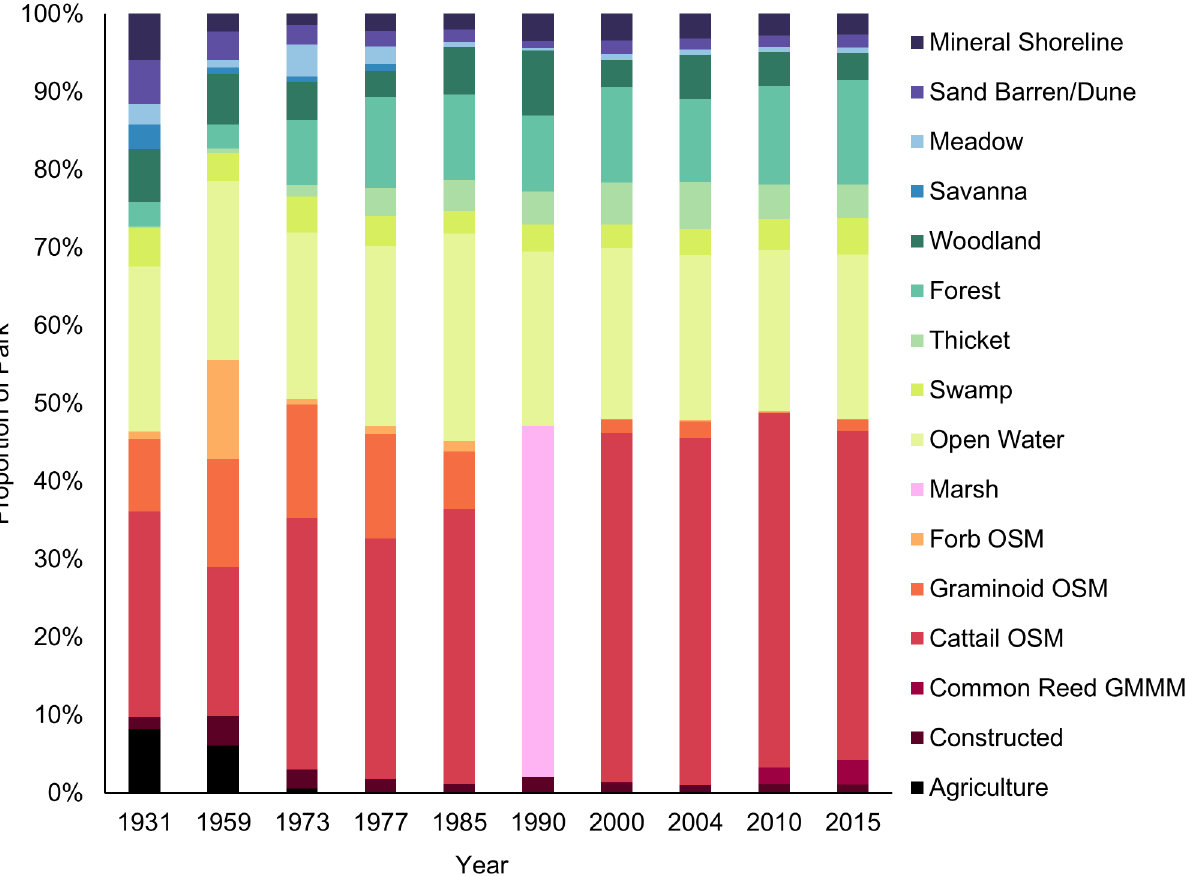
Fig 1. Habitat composition throughout the sampling period (1931 to 2015) in Point Pelee National Park. The quality of the 1990 image did not permit classification of marsh ecosites/vegetation types (i.e., common reed, cattail organic shallow marsh, graminoid organic shallow marsh, forb organic shallow marsh) and is only presented at the community level (marsh). Habitat types comprising < 0.5% of the park are not